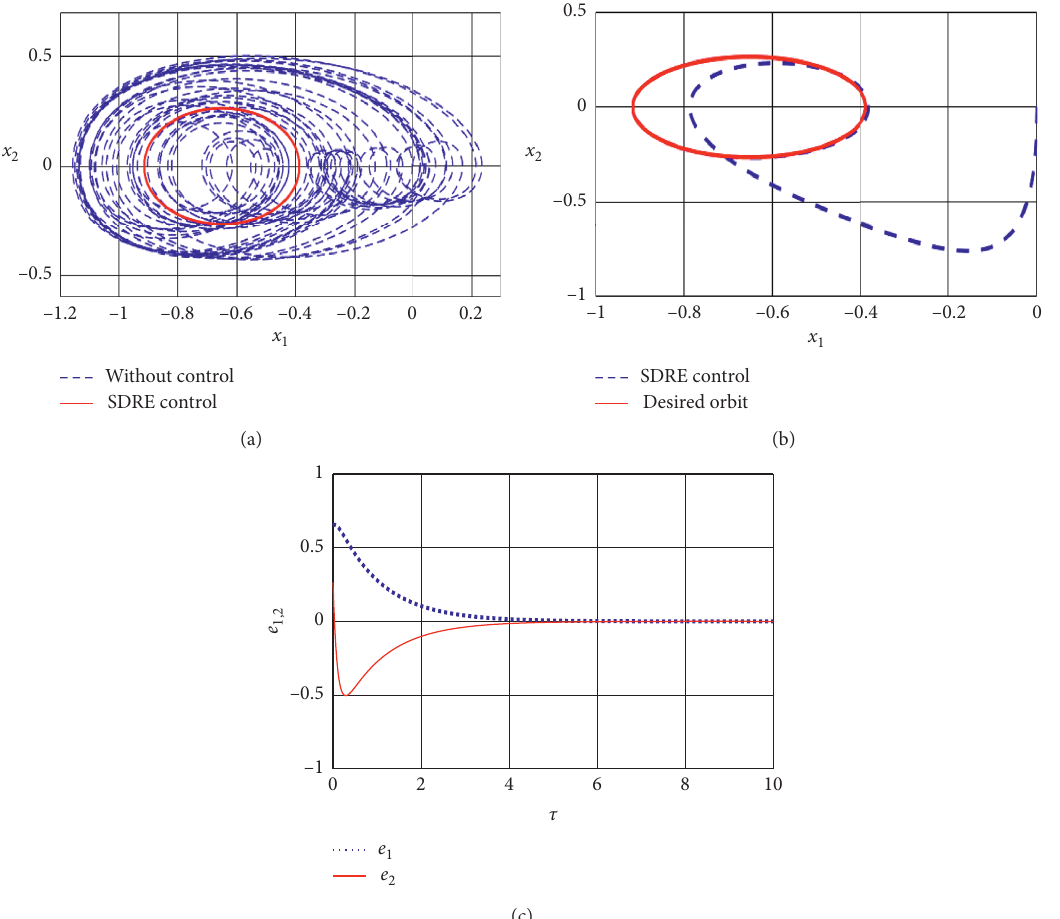
Figure 18: SDRE control: (a) phase portrait with control (solid line) and without control (dashed line); (b) trajectory of the control (dashed line) in comparison with the desired trajectory (solid line); (c) error variation e q � 0 . 3